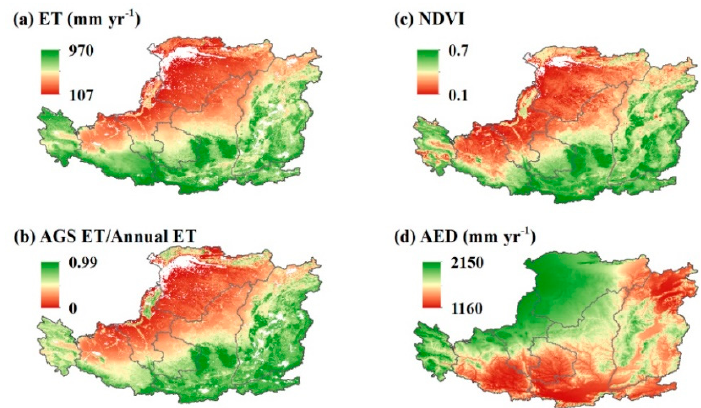
Figure 2. Spatial patterns of ( a ) mean annual evapotranspiration (ET), ( b ) the ratio of ET over active growing season to annual ET (AGS-ET/Annual ET ratio), ( c ) mean annual Normalized Difference Vegetation Index (NDVI), and ( d ) mean annual atmospheric evaporative demand (AED) averaged over 2000–2014 in the Chinese Loess